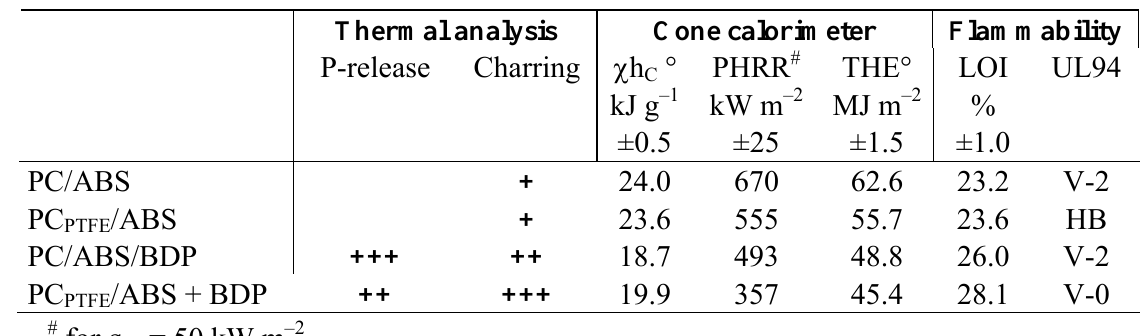
Table 9. Phosphorus release and charring determined by thermal analysis, combustion efficiency multiplied by effective heat of combustion ( χ⋅ h by cone calorimeter and flammability (LOI, UL 94) for PC/ABS, PC BDP, PC /ABS + PTFE